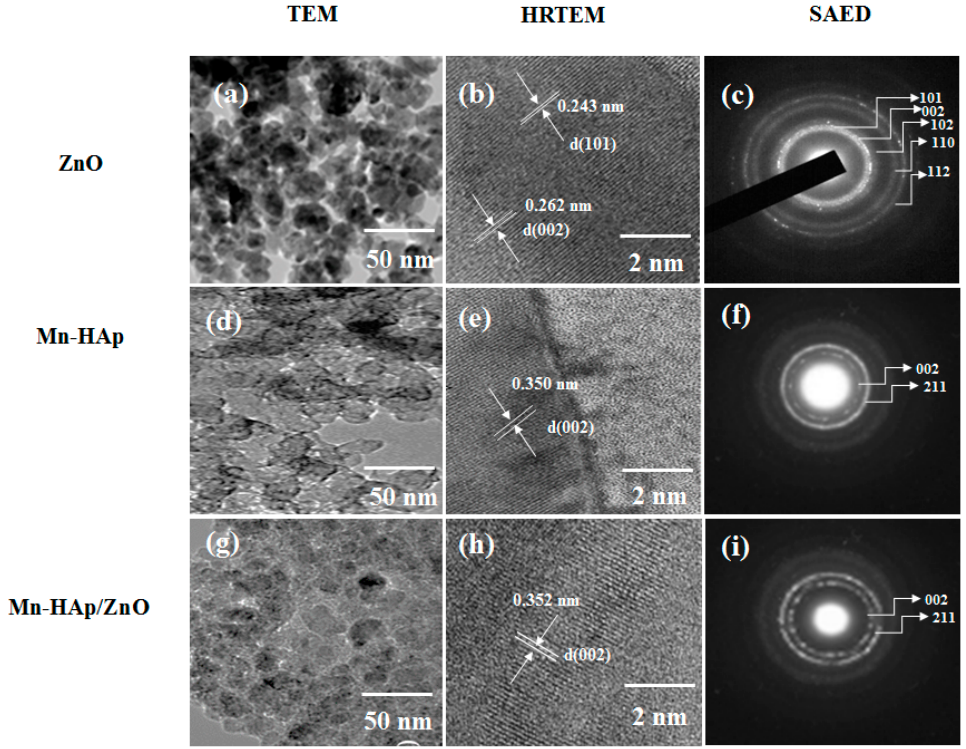
Figure 2. Transmission electron microscopy (TEM), high-resolution TEM (HRTEM), and SAED patterns of ( a – c ) ZnO, ( d – f ) Mn-HAp and ( g – i ) Mn-HAp/ZnO bilayer coating on 316L